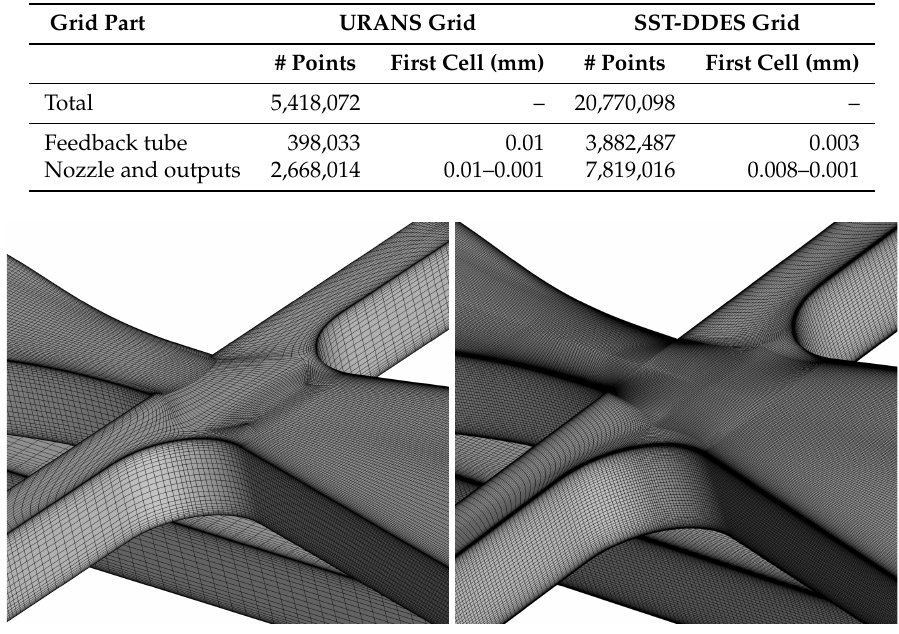
Figure 3. Detail of the surface computational grids for the URANS calculations with 5.5 million grid points ( left ) and for the hybrid SST-DDES ( right ), refined to nearly 21 million grid points in total, with 12 million inside the actuator. See Table 1 for